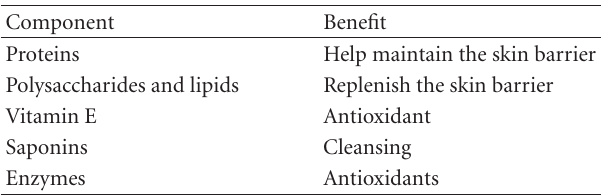
Table 1: Composition and beneficial properties of colloidal oatmeal